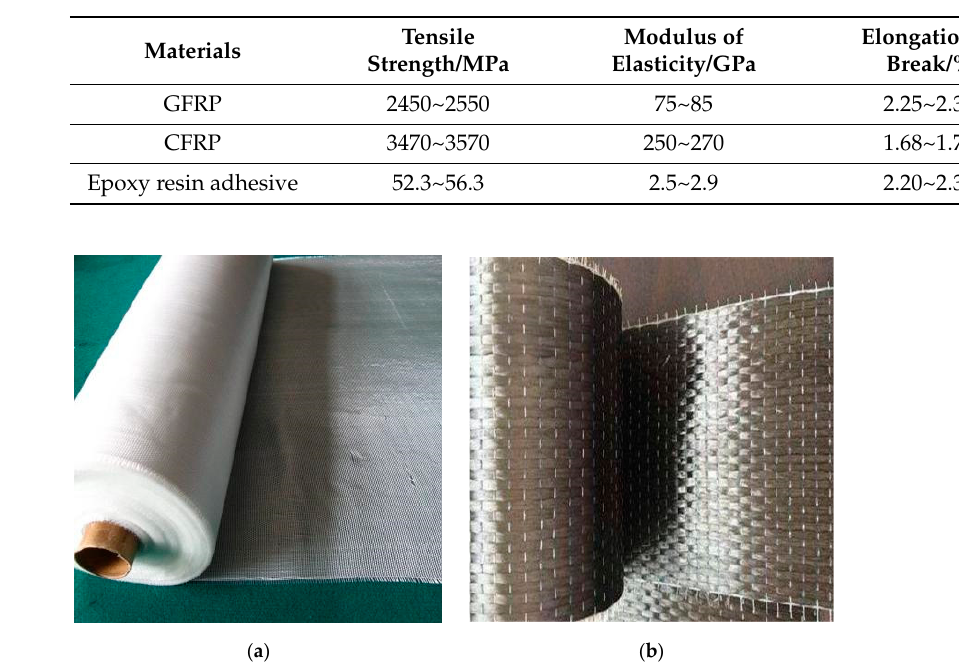
Table 1. Physical and mechanical properties of cement index.